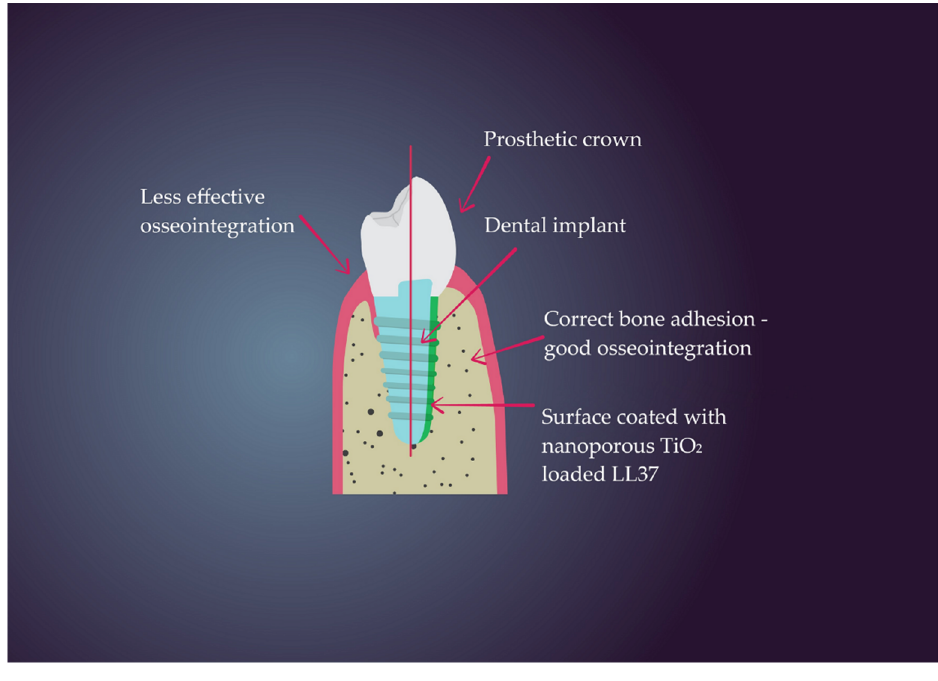
Figure 5. Ascheme showing difference in osseointegration between implant surface with and with- out coating.